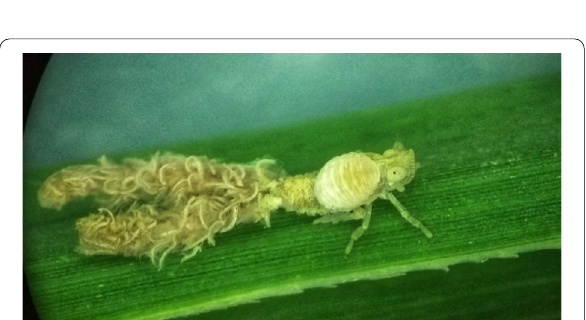
Fig. 5 Parasitized nymph of sugarcane pyrilla